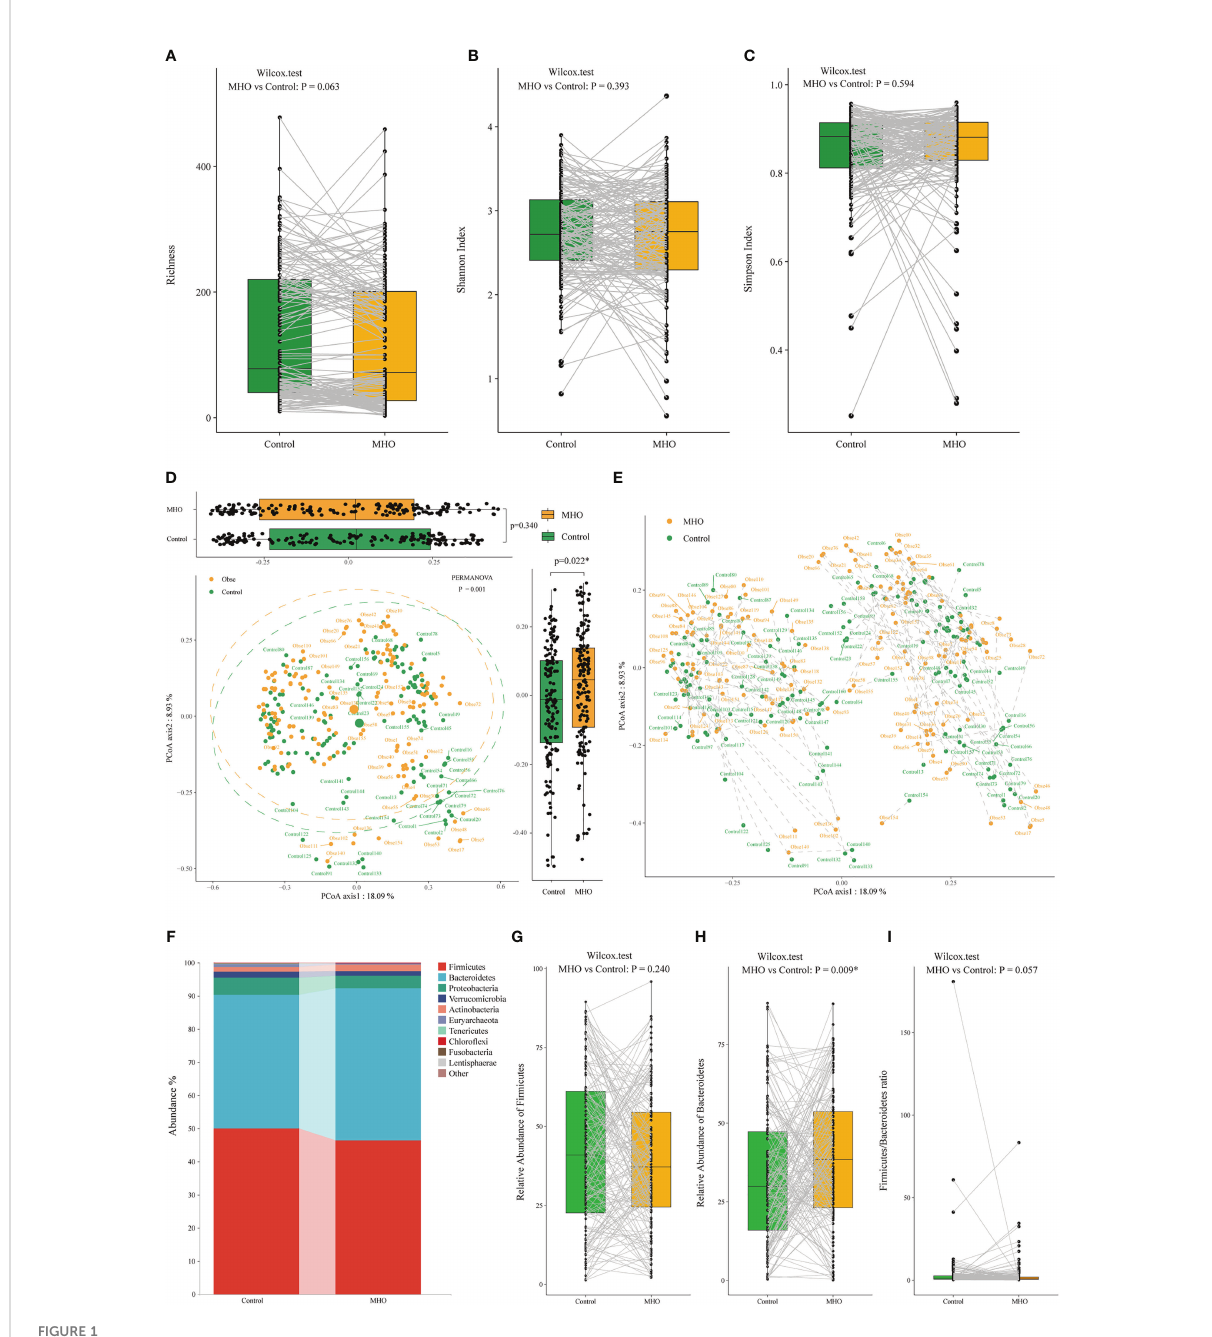
FIGURE 1 Alteration of gut microbiota in MHO individuals compared with their matched non-obese healthy controls according to the human metagenomic data. Alpha diversity was evaluated by the observed Richness (A) , Shannon index (B) , and Simpson index (C) . The gray lines indicate samples from MHO individuals and their matched non-obese healthy controls by age, sex, country, and Project ID. PCoAs of b -diversity were evaluated on species by Bray-Curtis distances (D) . Visualization of the distance of paired samples was shown in (E) . Each dot represents a sample. The difference in Bray-Curtis distances was calculated by the Mann – Whitney U test on Axis 1 ( p= 0.340) and 2 ( p= 0.022*), respectively. The dashed lines indicate a certain MHO patient was matched with a non-obese healthy control. The difference was calculated using the Wilcoxon Mann-Whitney U test. (F) The distribution of gut microbiota at the phylum levels in the both MHO and control groups. The abundance of Firmicutes (G) , Bacteroidetes (H) , and the F/B ratio (I) were compared between the two groups. MHO: Metabolically healthy obesity; PCoAs: Principal coordinate